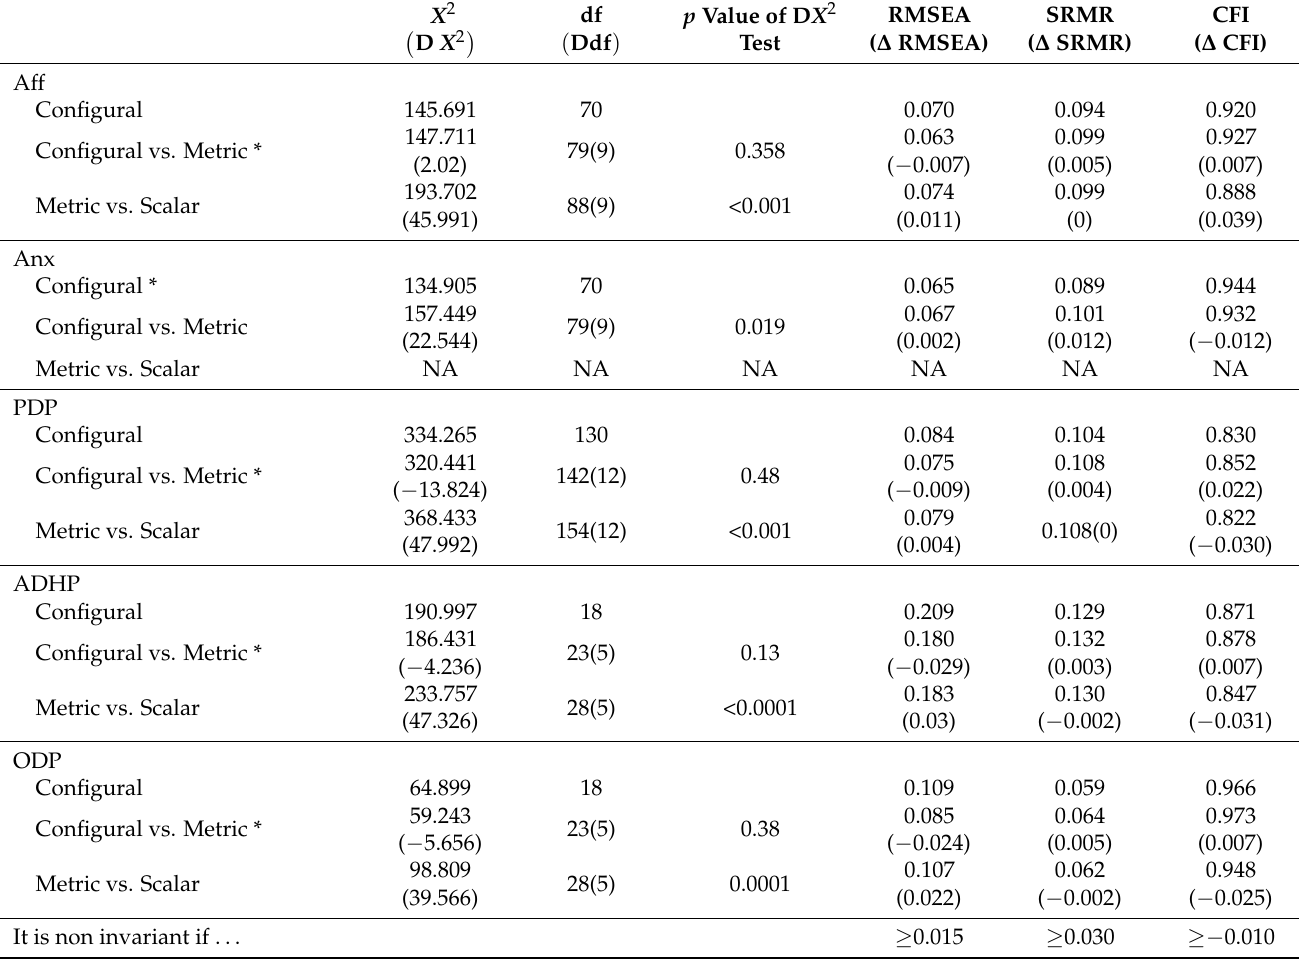
Table 2. Model comparison of CBCL DSM-oriented subscales (WLSMV estimation).